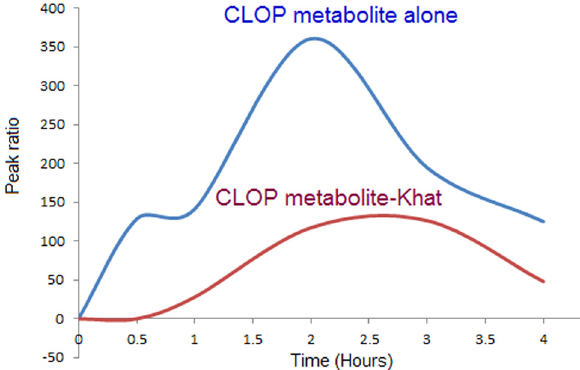
Figure 7: In fl uence of khat on the level of CLOP active metabolite over time in rat